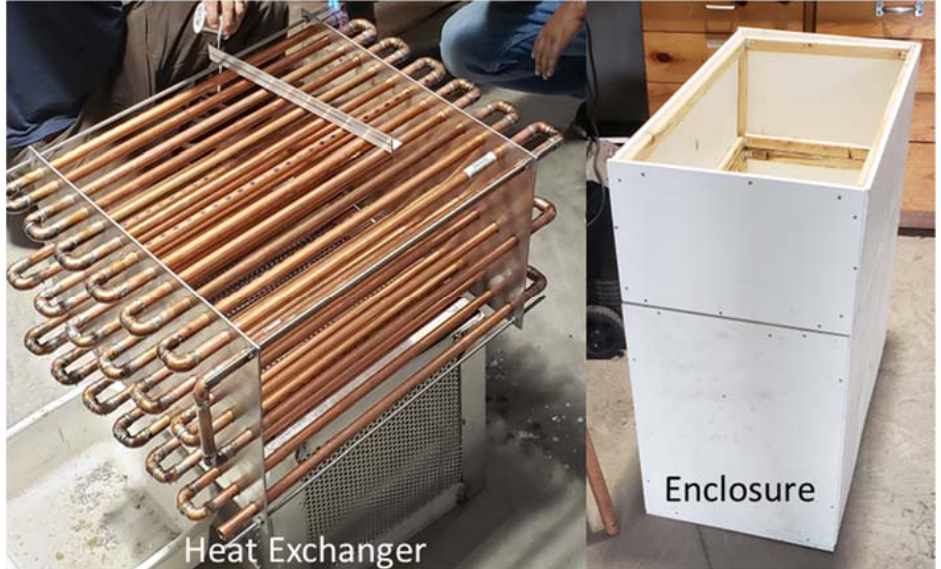
Figure 2. Picture of the heat exchanger and base enclosure (the enclosure is rotated so that the side that faces upstream is resting on the concrete and the aperture is facing up) used in the experiments.